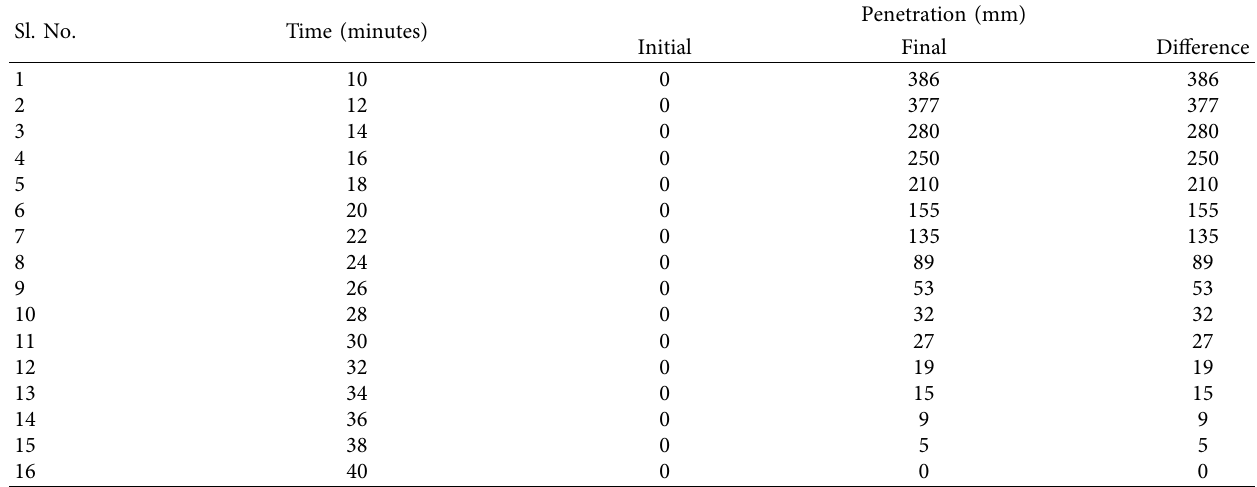
Table 8: Penetration test results of plastic.